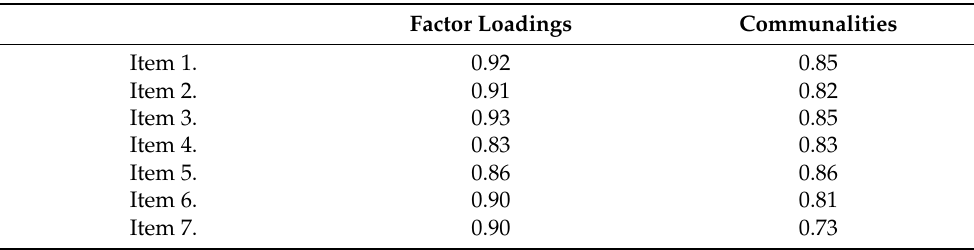
Figure 1. The scree plot of the sport-specific doping self-regulatory efficacy scale.